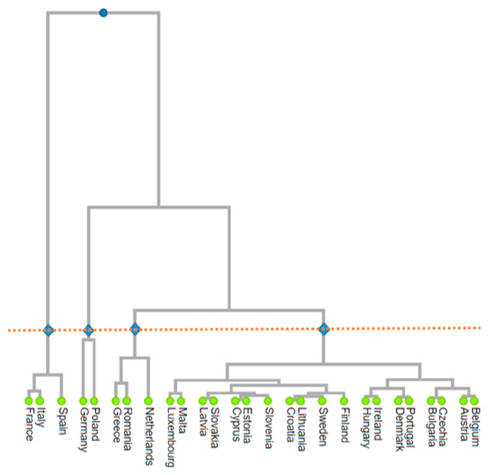
Figure 10. The dendrogram associated to hierarchical cluster analysis. Source: Authors’ calculation and representation, according to Eurostat (2020) data.